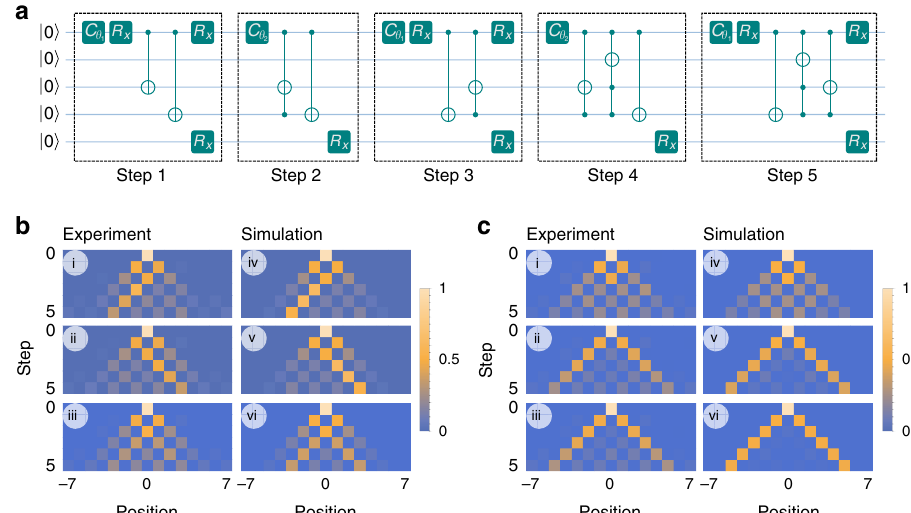
¼ 0 j i ¼ 1 j i , b ii and b iv ψ j i , b iii and b vi c c c c